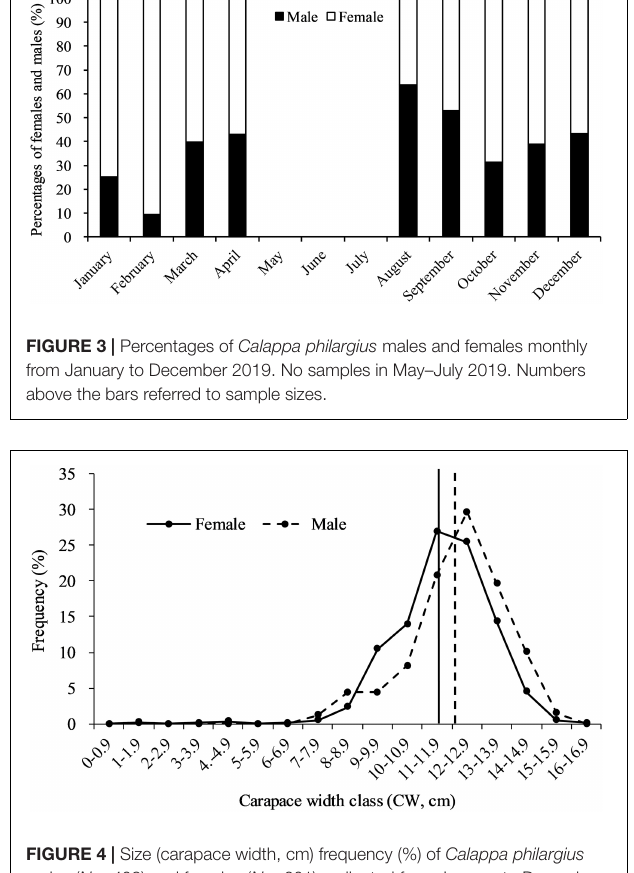
FIGURE 4 | Size (carapace width, cm) frequency (%) of Calappa philargius males ( N = 408) and females ( N = 601), collected from January to December 2019. No samples in May–July 2019. Vertical lines indicate the average sizes of males and females.